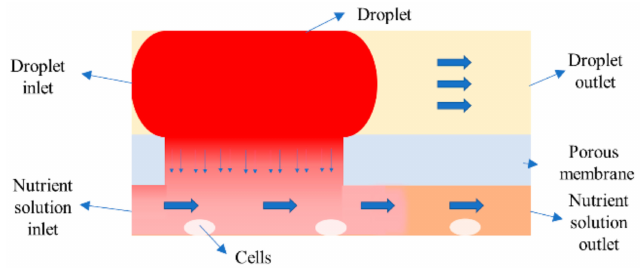
Figure 3. Diffusion process of rhodamine solution from microdroplet to